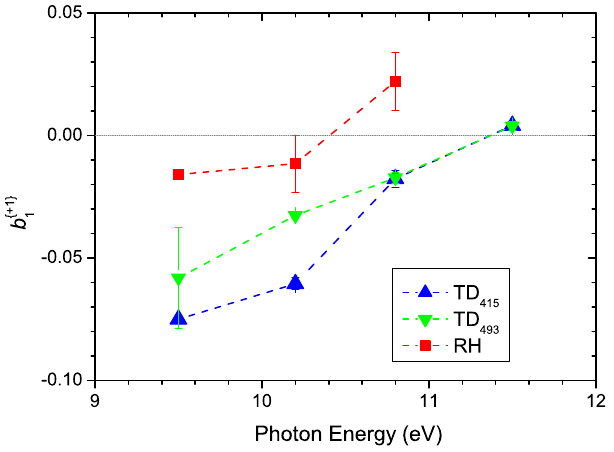
Fig. 10 Survival rate ( P /( P + F )) of the Pro parent (P) ion ( m/z 115) vs. Fig. 9 Parent mass- fi ltered b fþ 1 g for L -pro HOMO ionization. These are 1 fragment (F) ( m/z 70 + m/z 43). The data are shown as a function of the plotted as mean values, formed by PES intensity weighted averaging across photon energy and temperature: 384 K (TD 415 ), 452 K (TD 493 ), and 600 K the PECD pro fi les extracted from m / z 115 fi ltered electron images. Error (RH). The data have been obtained from the mass spectra recorded during bars correspond to statistical (standard deviation) errors (for some points the PECD PEPICO acquisition. The statistical error bars (standard within the symbol size). Broken lines are to guide the eye only. deviations) are within the symbol